Question: What kind of plot is shown here?
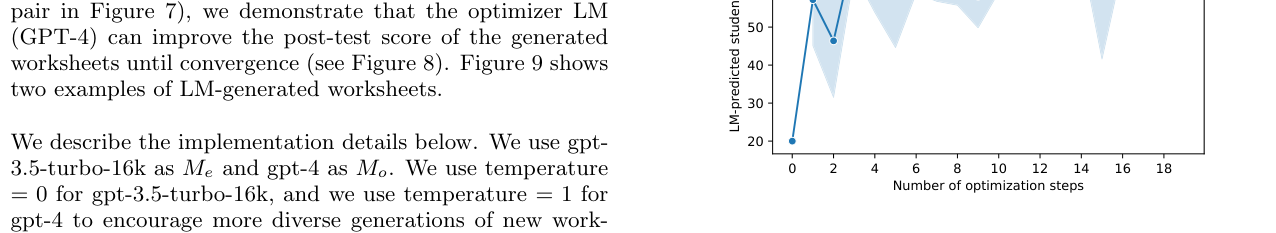
Answer: bar